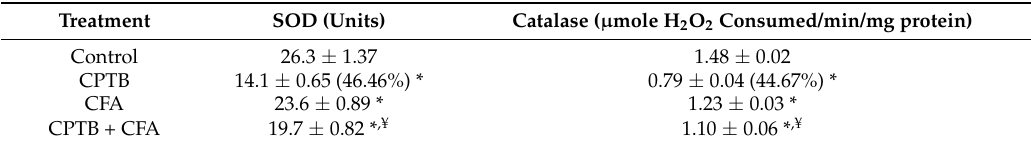
Table 4. Protective effect of caffeic acid on capecitabine-induced changes in activities of hepatic superoxide dismutase (SOD) and catalase in rats.